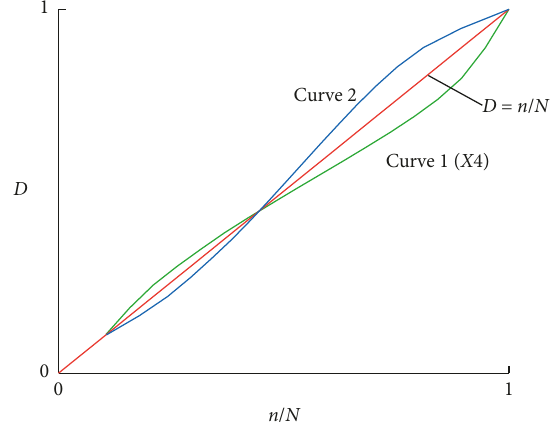
Figure 9: Rock salt damage evolution curve and inverse function.